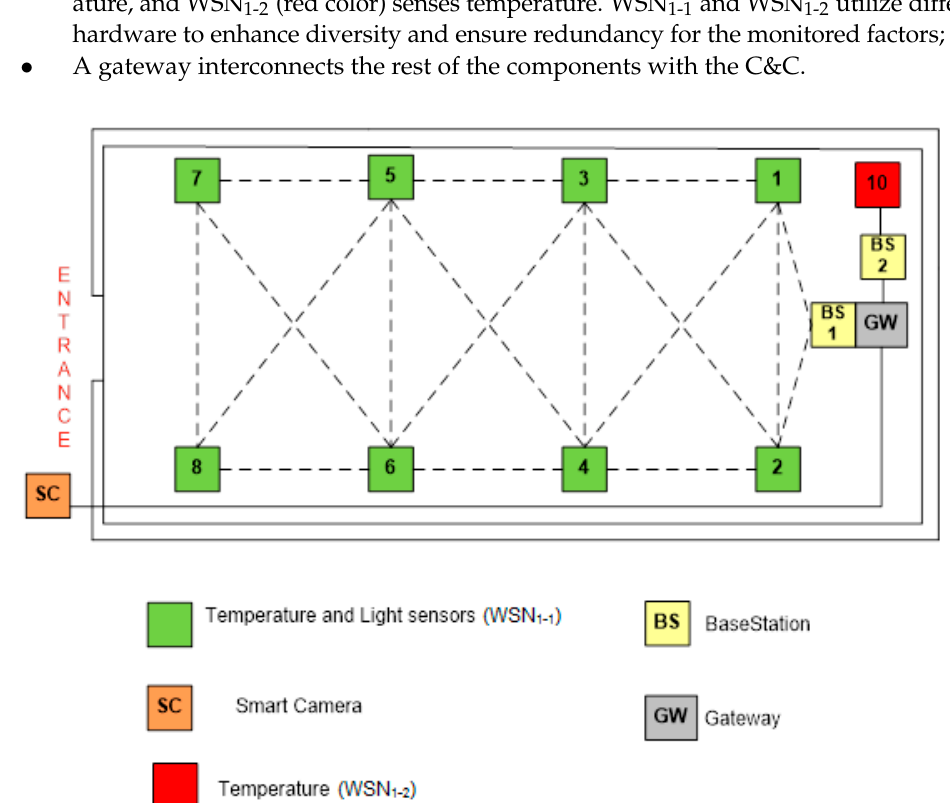
Figure 5. The internal wireless sensor network (WSN) for the carriage setting.